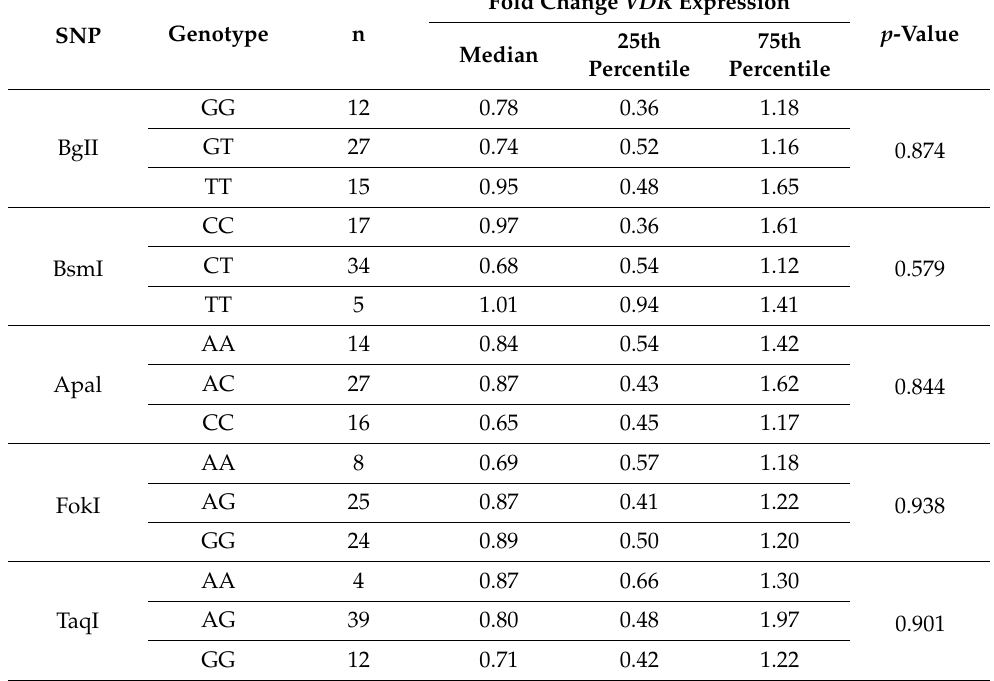
Table 2. VDR expression according to the genotypes.